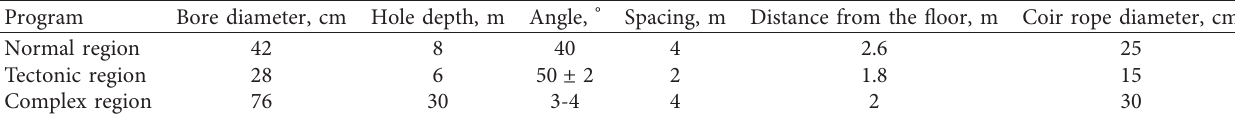
Table 1: Programs and parameters of the flexible support technique